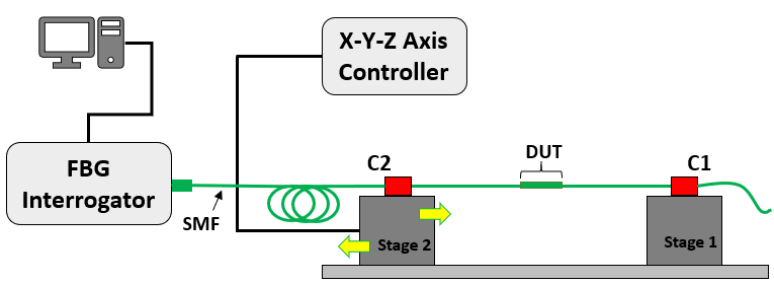
Figure 10. Strain testing experimental set up.